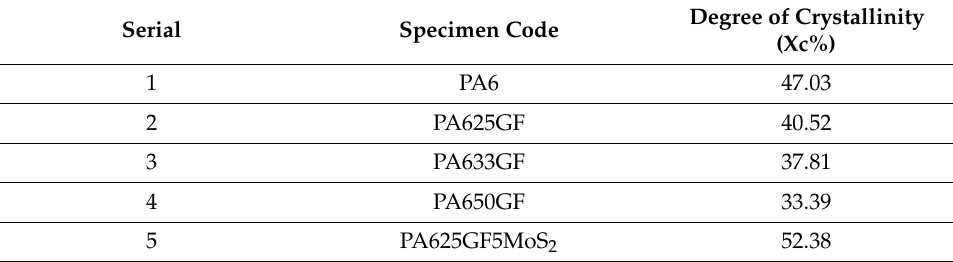
Table 6. Degree of crystallinity of PA6 and PA6 composites .